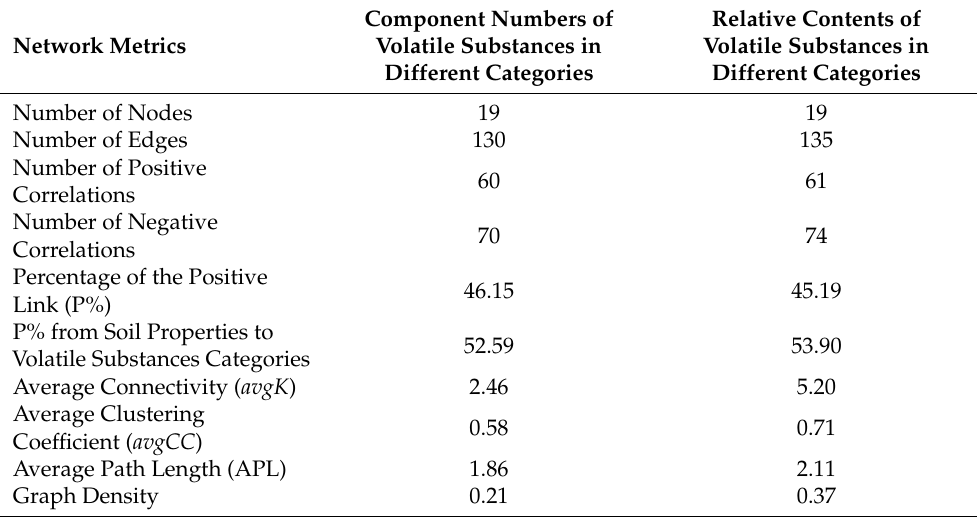
Figure 3. Network interaction diagram of the component numbers and relative contents of volatile substances in different categories in monoculture ( a ) and intercropping ( b ). Red lines indicate positive correlations, while blue lines indicate negative correlations. The thickness of the lines represents the correlation size. The size of the points represents the magnitude of relative types and contents of volatile components. Table 2. Topological properties of co-occurring soil and volatile substances networks obtained in different cultivation